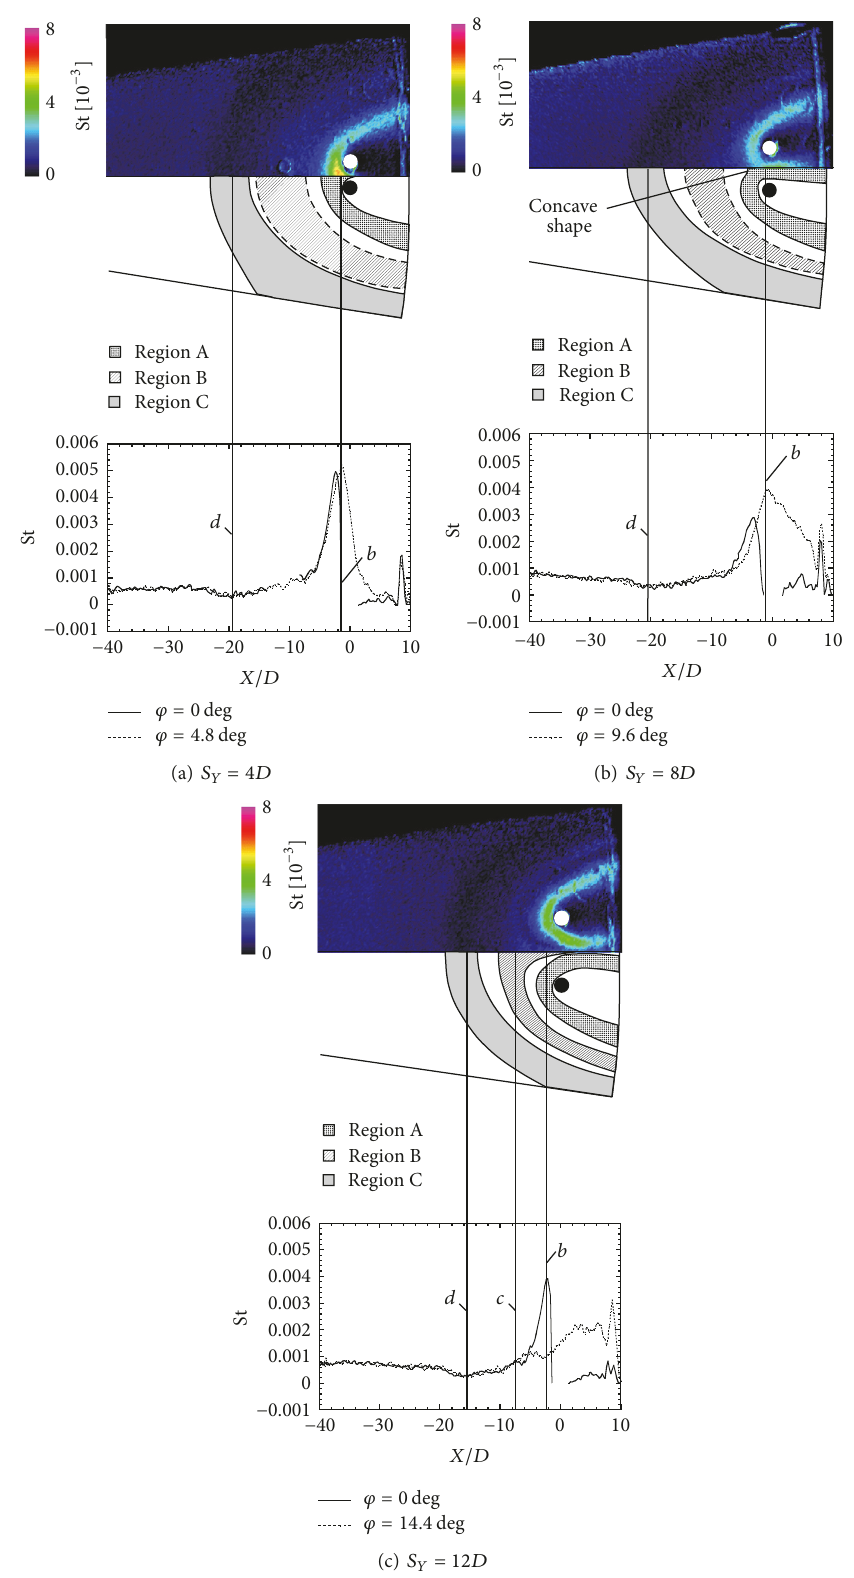
Figure 16: Surface St distributions induced by parallel dual injections with each spacing of 𝑆 𝑌 (upper figures), schematics of heating patterns (middle figures), and one-dimensional St profile on the middle of dual injectors ( 𝜑 = 4.8, 9.6, and 14.4 deg) and a line through SJ1 ( 𝜑 = 0 deg) (lower figures). Unclear boundaries of region B are illustrated with broken lines in the middle figures. A section of the St profile at 𝑆 𝑦 = 4𝐷 is not shown due to a measurement